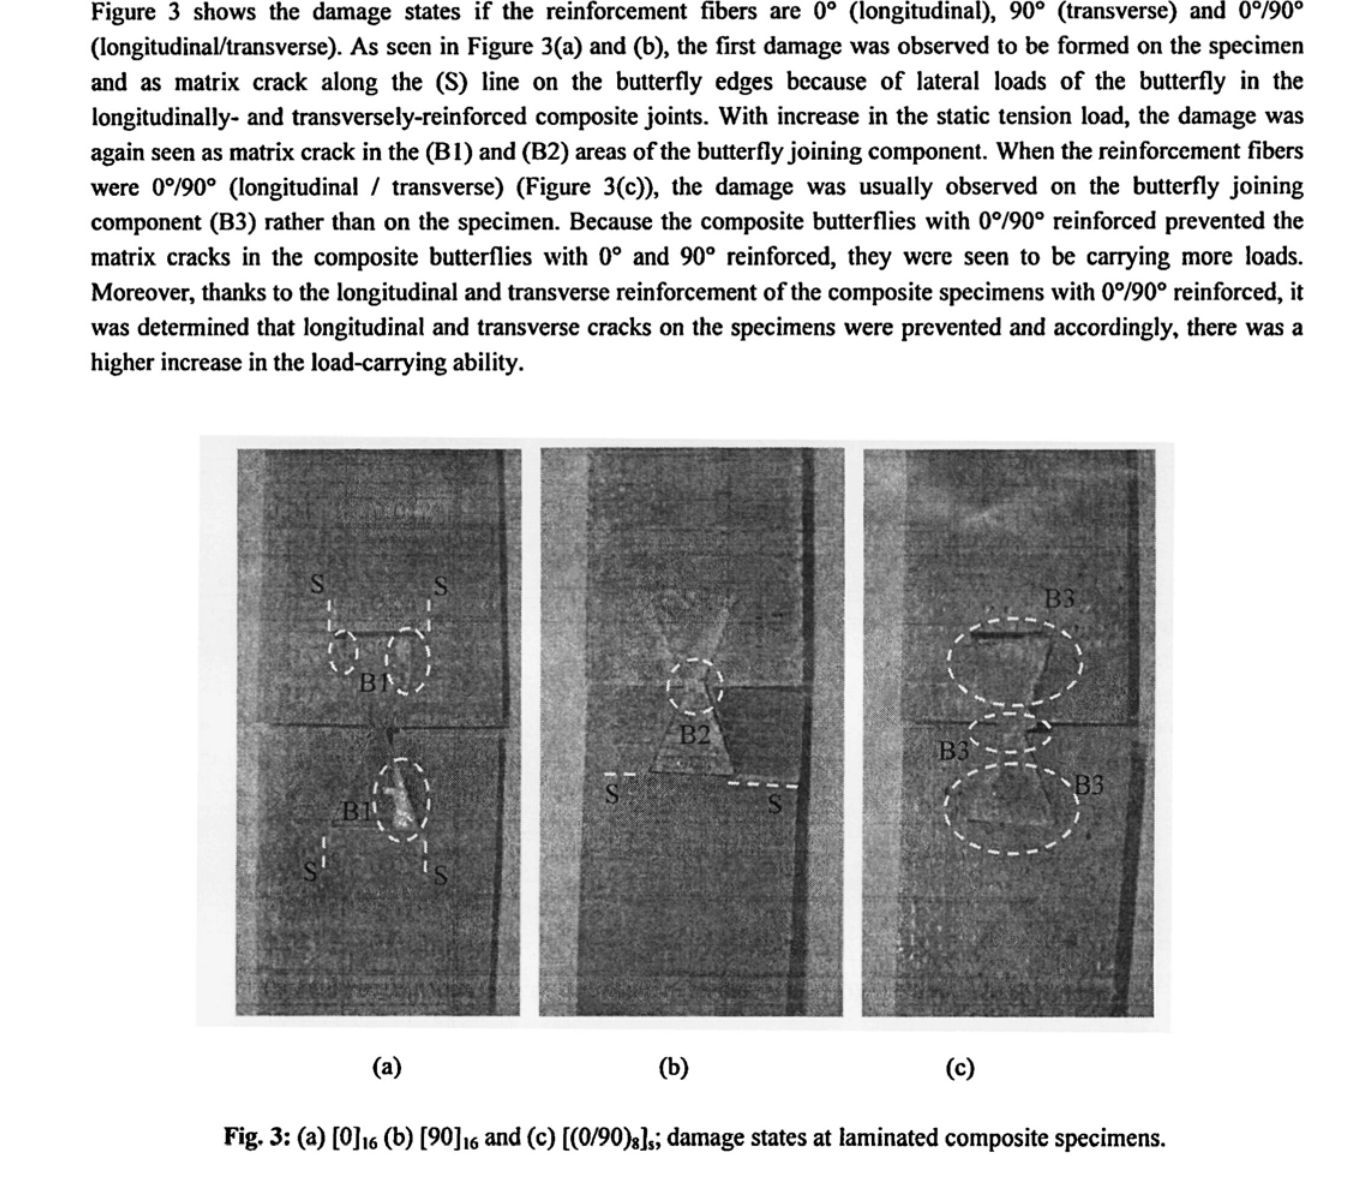
] ; damage states at laminated composite 8 s